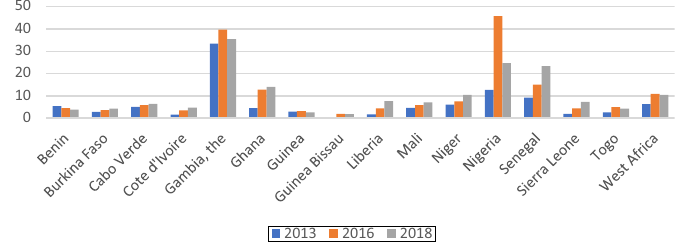
Figure 4. Debt Service (as % of Exports) Source: African Development Bank (AfDB,